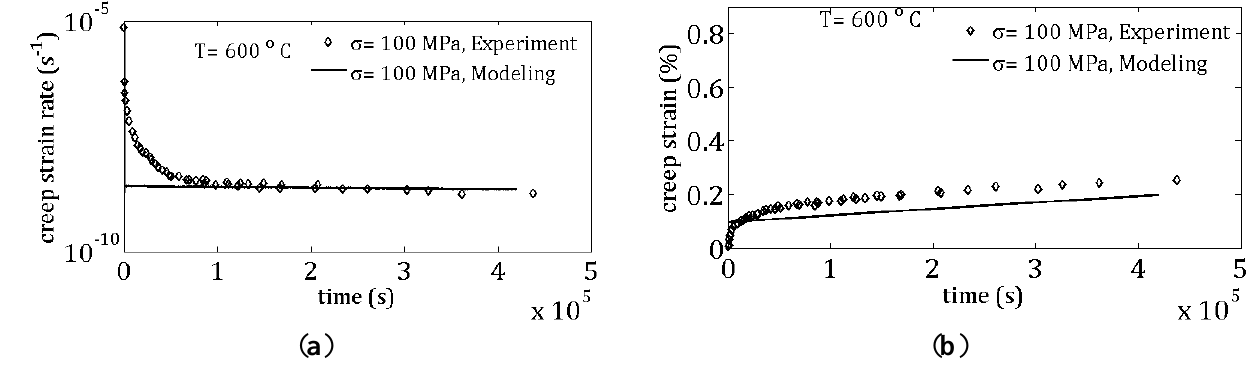
Figure 7. Creep results from experiments and finite element simulation for 100 MPa and 600 °C: ( a ) creep strain rate versus time; and ( b ) true creep strain versus time.